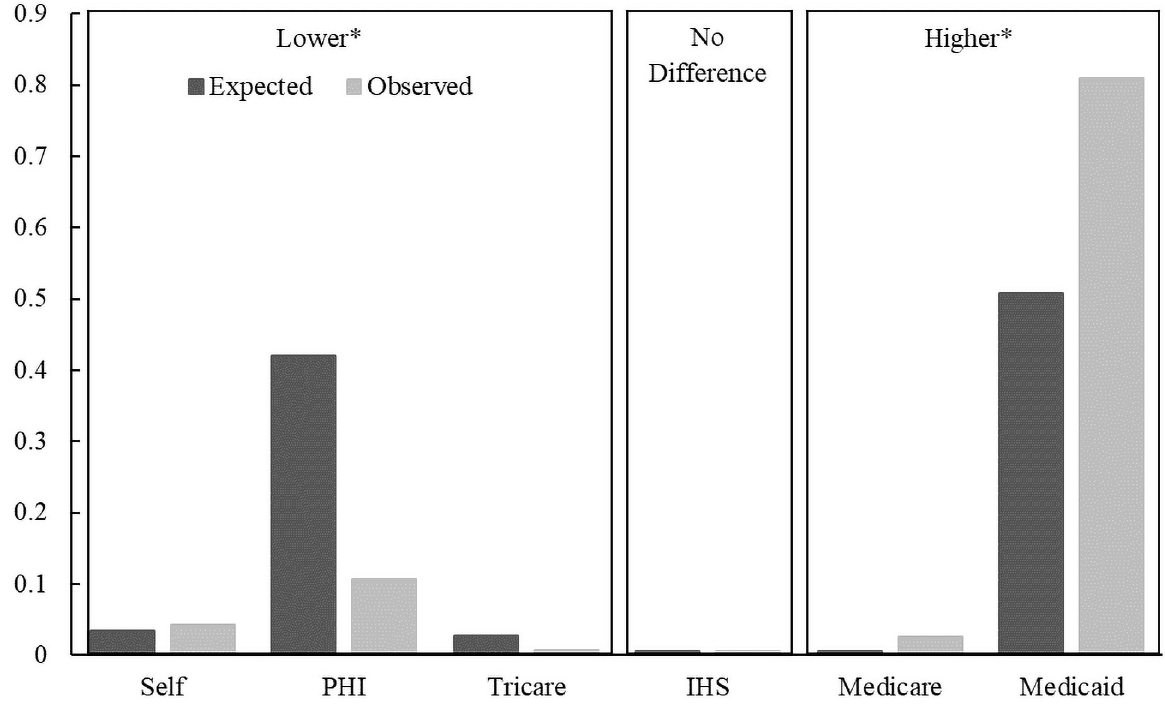
Fig 5. Comparison of the observed versus expected proportions of opioid dependence at the time of giving birth in each payor group utilized for mothers. Boxes labelled higher or lower mean that the observed proportions are significantly higher or lower than the expected proportion after post-hoc comparisons that incorporate a Bonferroni correction with six groups (p < 0.001/6). PHI: Private Health Insurance, Self: Self Pay, IHS: Indian Health Services.